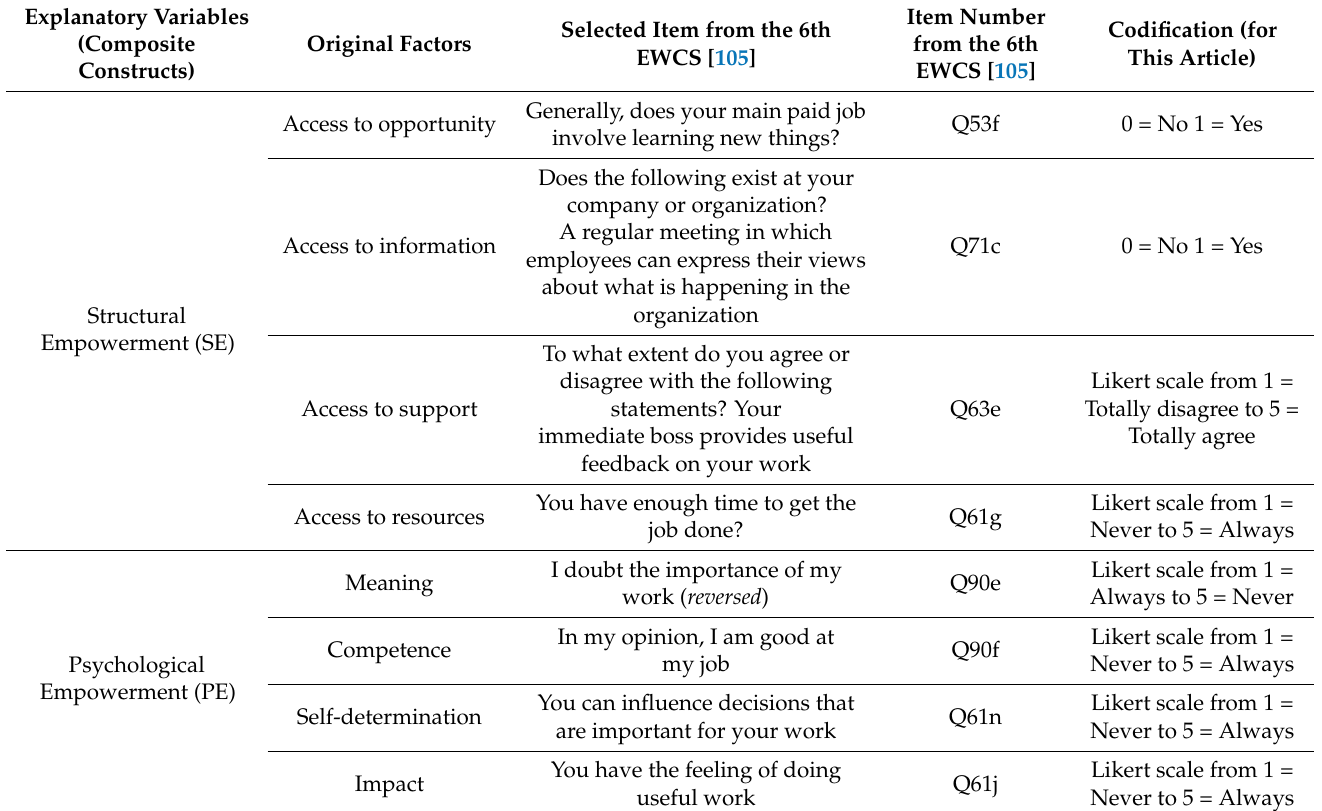
Table 1. Measurement of the criterion